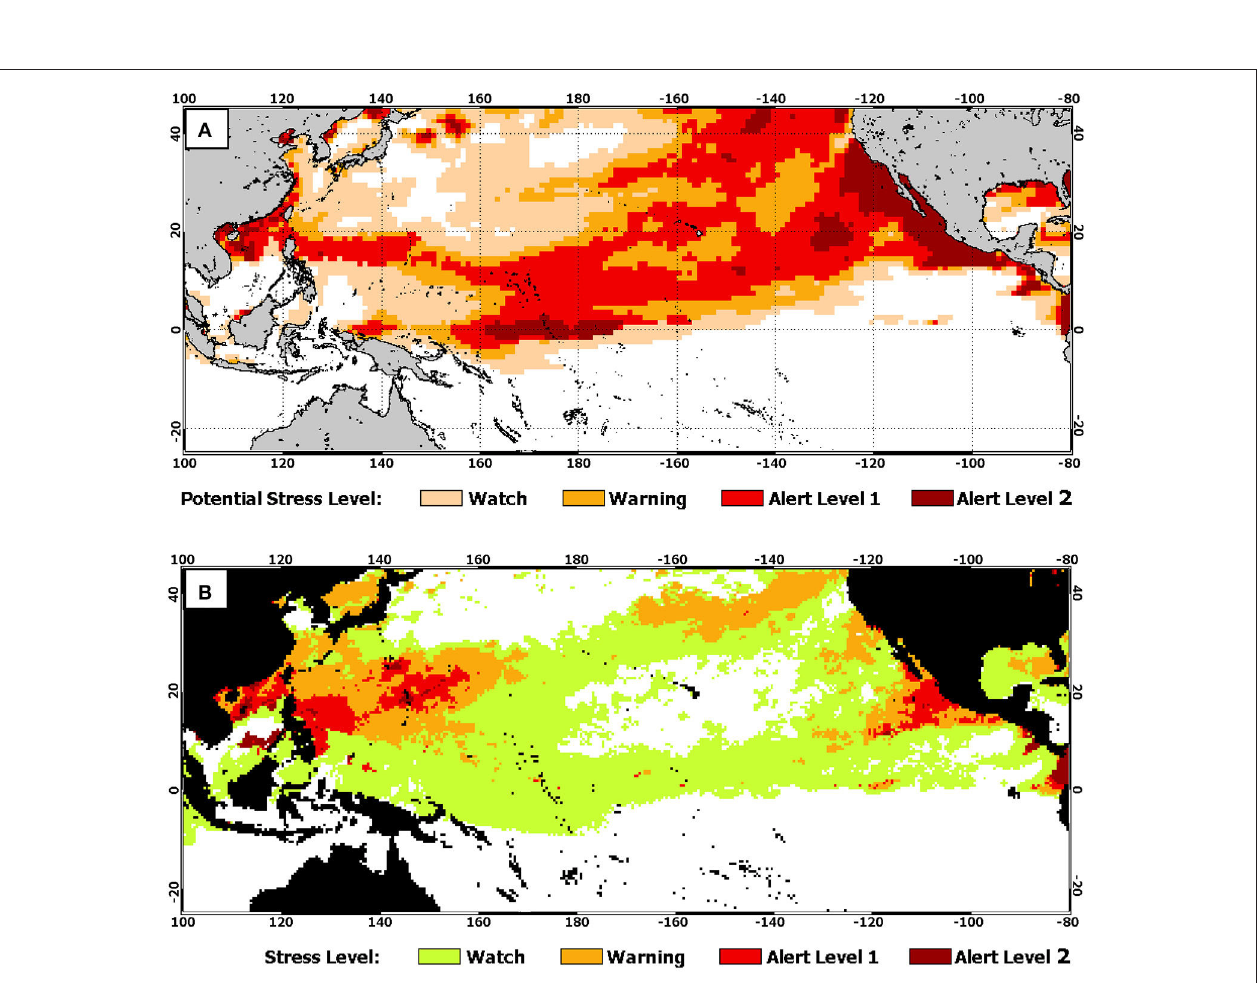
FIGURE 11 | CRW’s (A) 4-Month Outlook (Version 3) of 60% probability issued on June 24, 2014 for July–October 2014, predicting Alert Level 1 in the Commonwealth of the Northern Mariana Islands (CNMI), Guam, and the Main Hawaiian Islands (MHI), and the (B) monthly maximum 50km satellite Bleaching Alert Area for July 2014, observing Alert Levels 1 and 2 in the